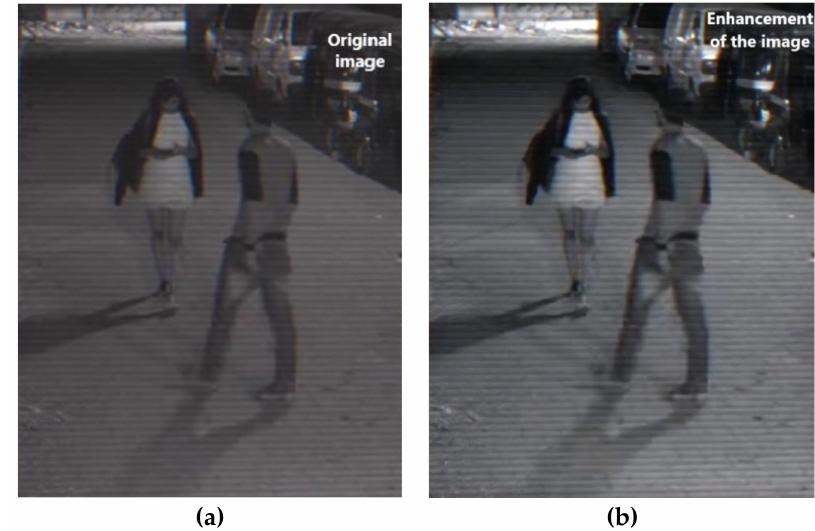
Figure 10. Preprocessing of the images to ensure a better quality of input images in our system. ( a ) The original image, ( b ) the image on which we apply a normalization function to distribute the pixel intensities from 0 to 255; this will enhance the image without losing